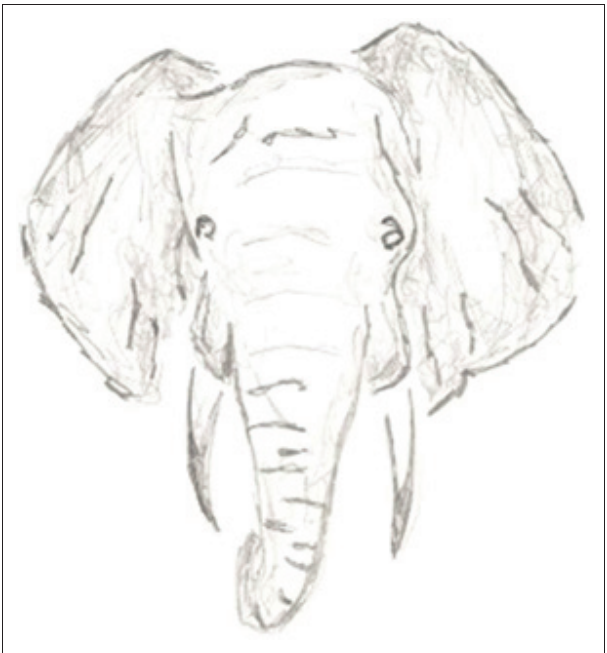
FIGURE 2: Illustration from Nadine’s digital